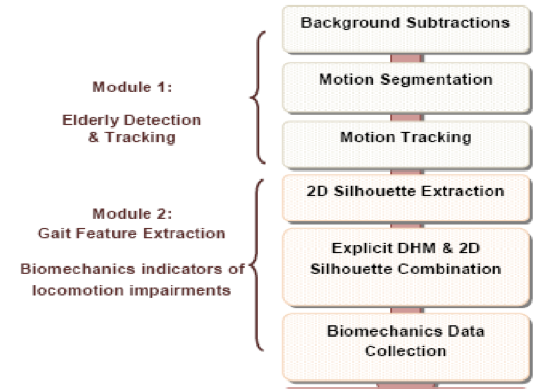
Figure 3: Schema of the image processing method.